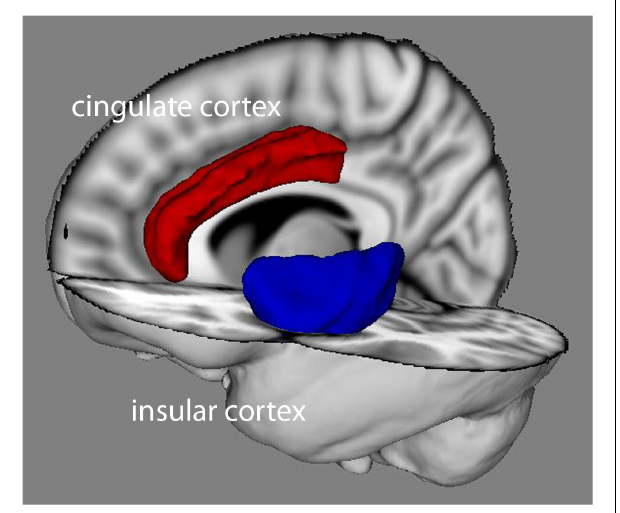
FIGURE 2 |The human cingulate (red) and insular (blue) cortices. Image generated using Mango (http://ric.uthscsa.edu/mango/).